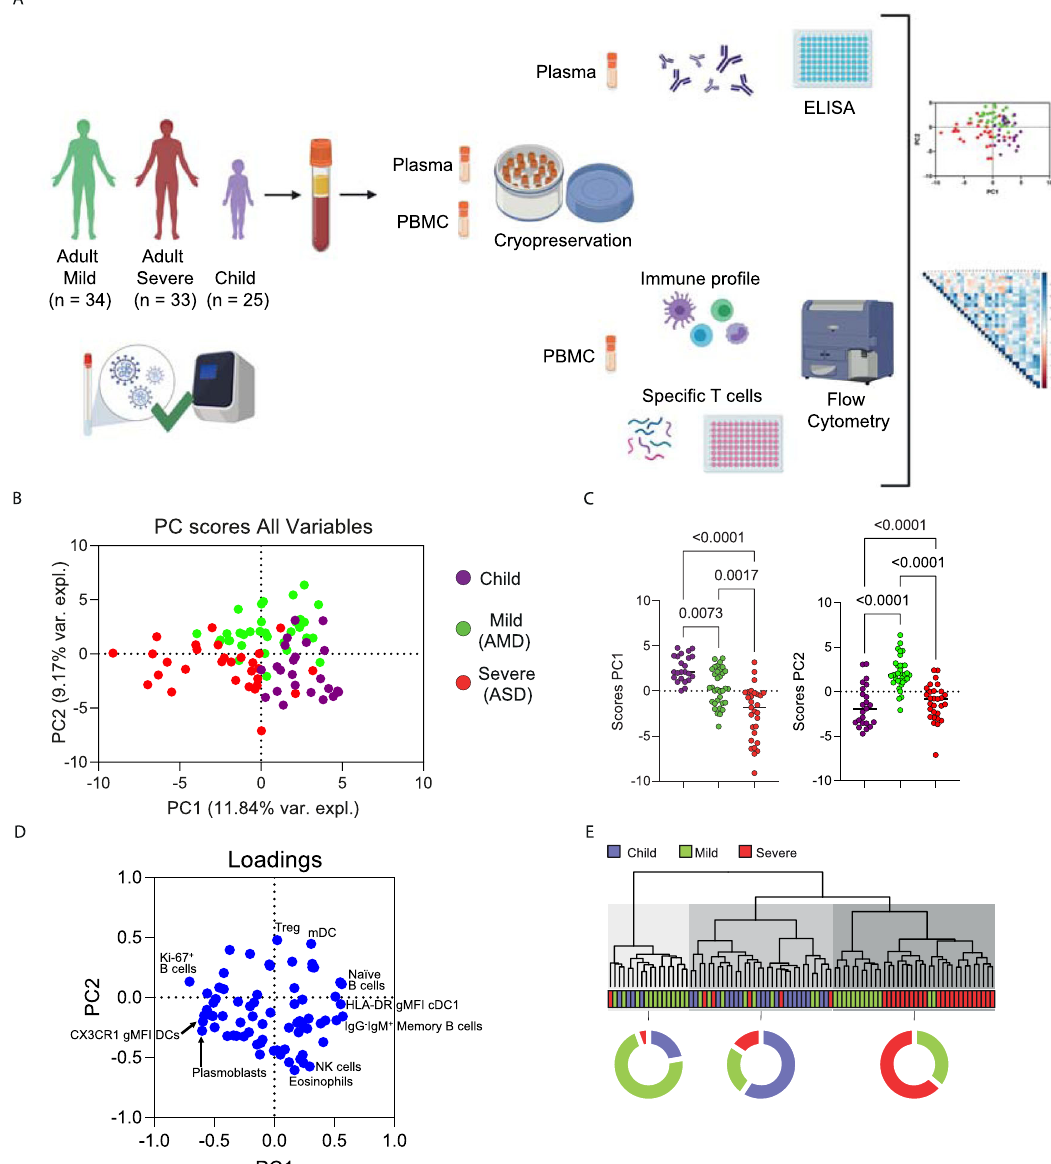
Fig. 1 Experimental approach and differential immune pro fi le of children, mild and adult patients by principal component analysis. A Graphical representation of the study design; B – E Principal component analysis of the clusters of pediatric (purple) and adult patients with mild (green) and severe (red) disease; each dot represents a patient, color coded. B Distribution of clusters by PC1 and PC2; C comparison of scores for each PC by analysis of variance (Kruskal – Wallis) with P values indicated over brackets, the horizontal bar representing the median. D Contribution of variables (loadings) to PC1xPC2. Each blue dot is a variable. E Hierarchical clustering analysis of immune variables. Each shade of gray is a cluster with a representative distribution between groups. Graphical study design was created with biorender.com (accessed on 20 October 2021). Source data are provided as a Source Data fi